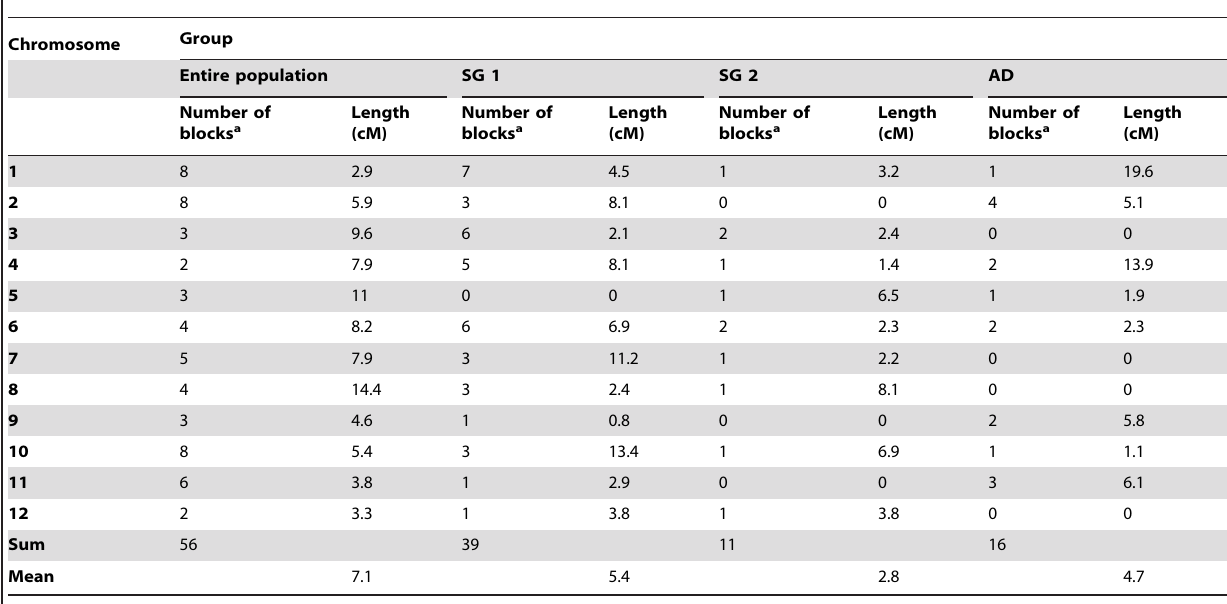
Table 6. Number of linkage disequilibrium (LD) blocks per chromosome and their average length per chromosome in centiMorgan(cM) in the entire population and